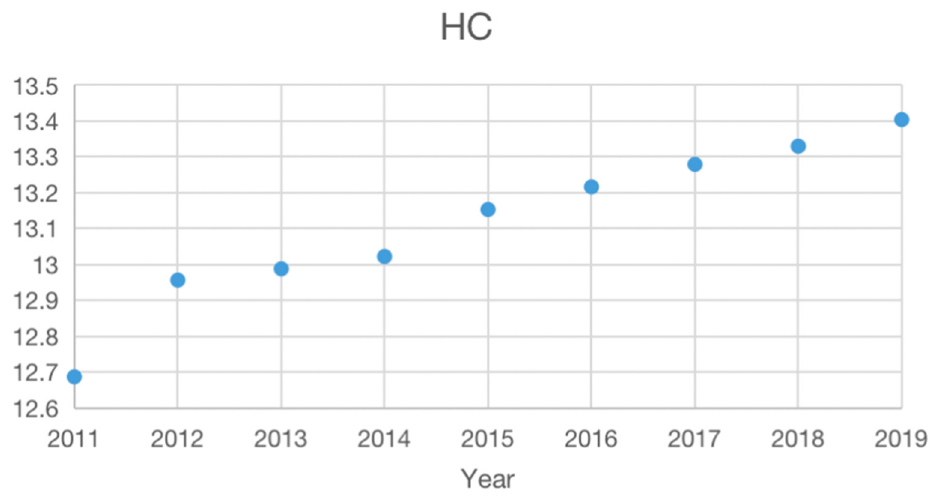
Figure 3. The change trend of HC from 2011 to 2019.